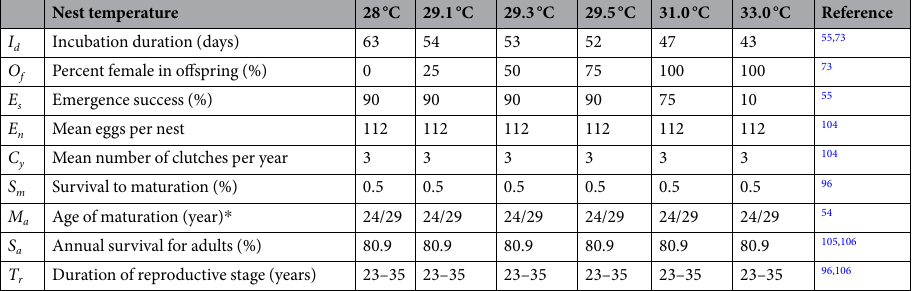
Table 3. Summary of the demographic parameters used in the present study. Six different temperatures during the middle third of the incubation were considered. Some of the parameters were assumed to be constant in the range of temperatures considered. * First value for turtles of Mediterranean origin and second value for turtles of Atlantic